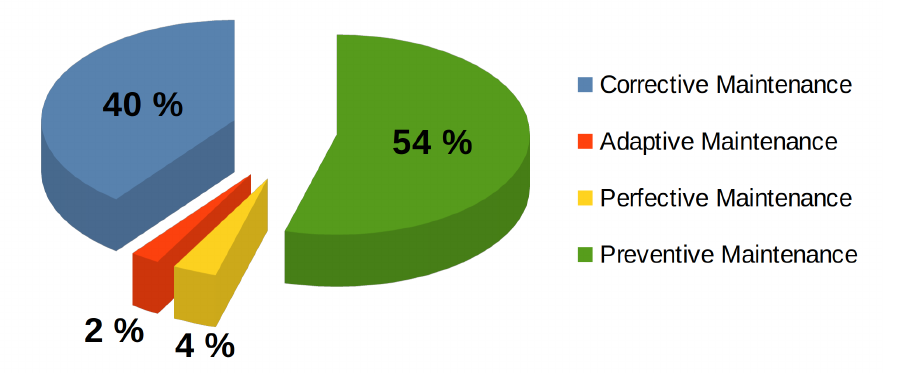
Figure 10. Types of